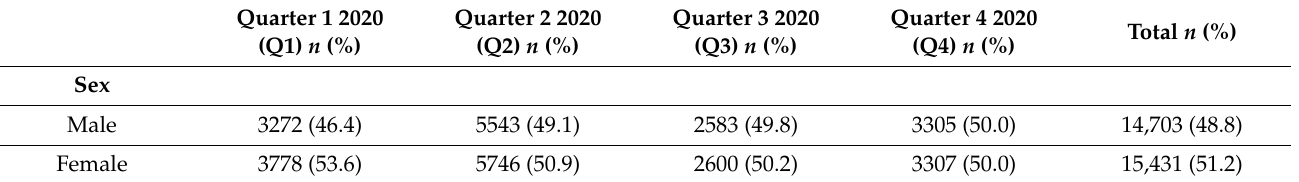
Table 1. Participant demographics in the sample by the quarters of 2020.